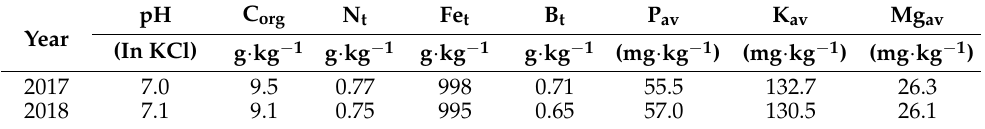
Table 1. Some soil properties in the layer 0–0.25 m before experiment establishment in 2017 and